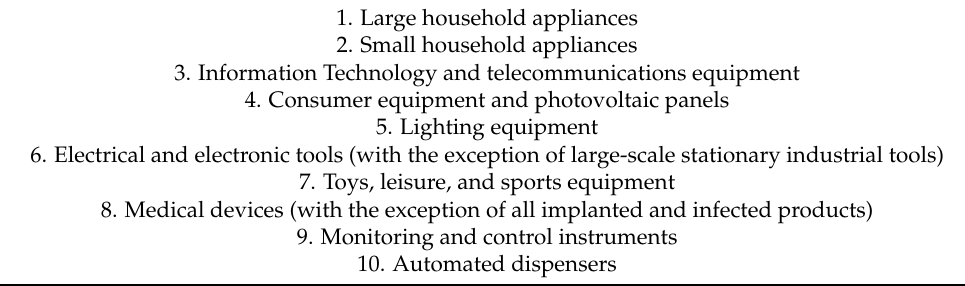
Table 1. South Africa e-waste categories